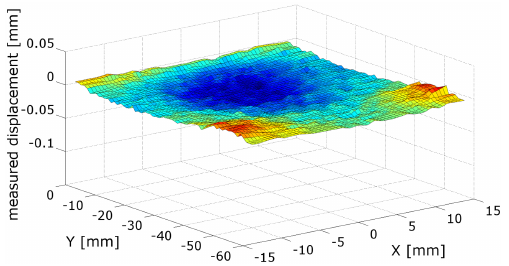
Figure 7. Heat treatment in a furnace.